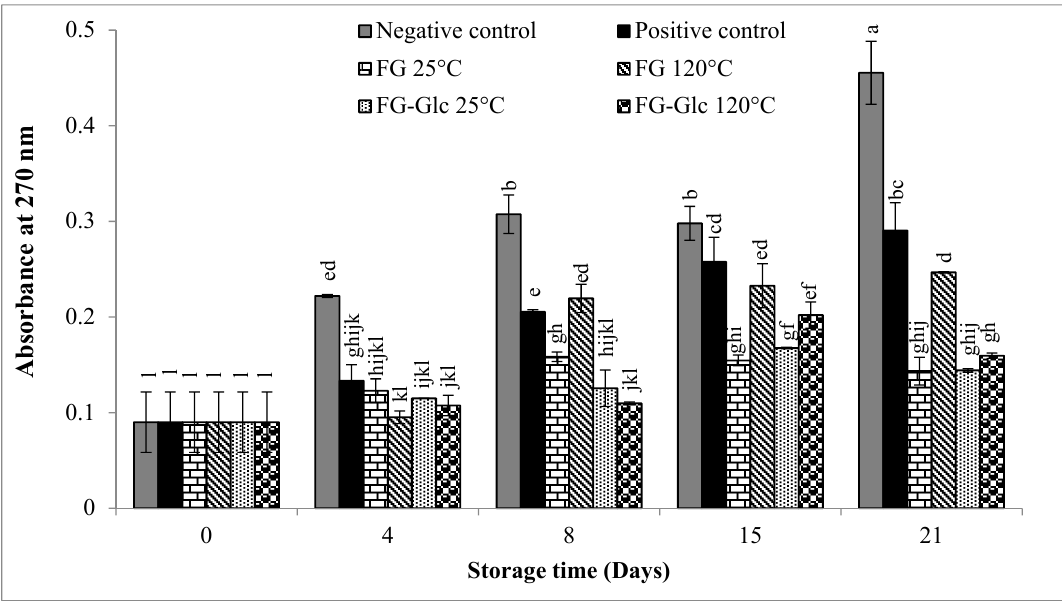
Figure 4. Absorbance at 270 nm of flaxseed oil packaged or not in different gelatin pouches as a function of storage time. Means with different superscripts (a-l) indicate a significant difference ( p ˂ 0.05).